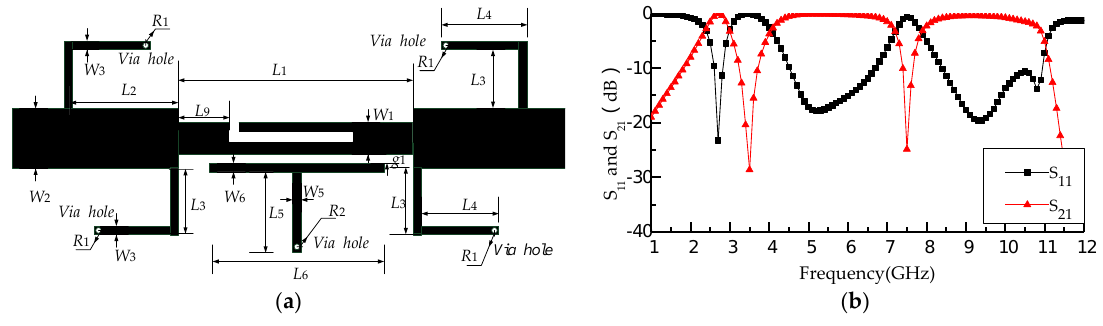
Figure 3. ( a ) The circuit of the proposed filter; ( b ) simulation results of the proposed filter.